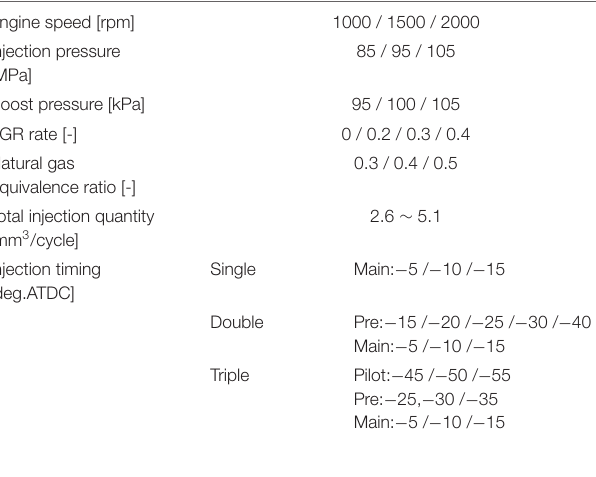
TABLE 5 | Experiment condition for the DFE combustion control model identification.